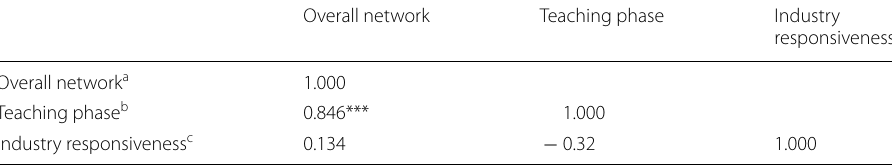
a The overall period‑divisional/overall dynamic network efficiency over the period reported b The period‑divisional/dynamic efficiency of teaching phase over the period reported c The period‑divisional/dynamic efficiency of industry responsiveness over the period reported *** denotes the significance level at